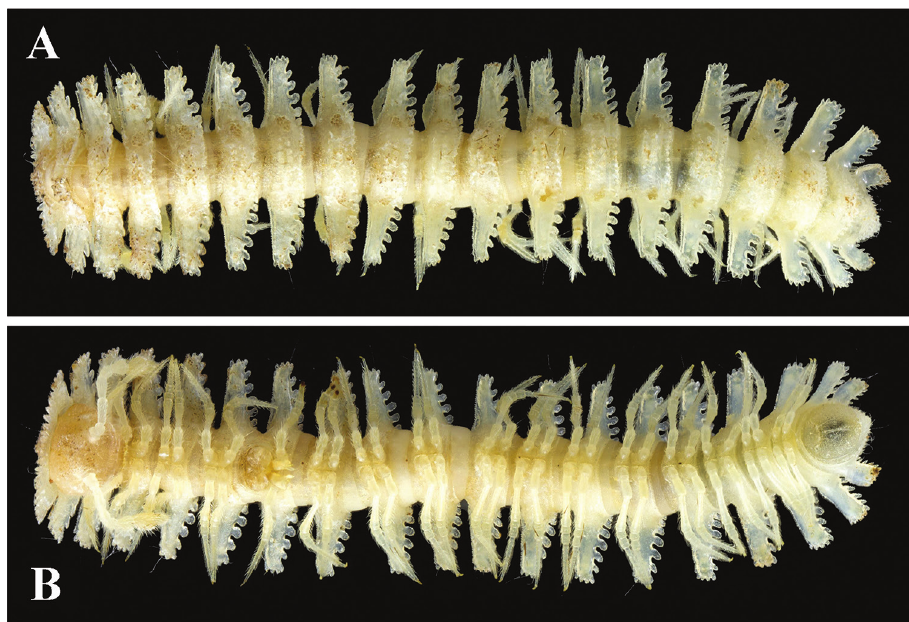
Figure 7. Trichopeltis reflexus sp. n., ♂ paratype. A–B habitus, dorsal and ventral views, respectively.